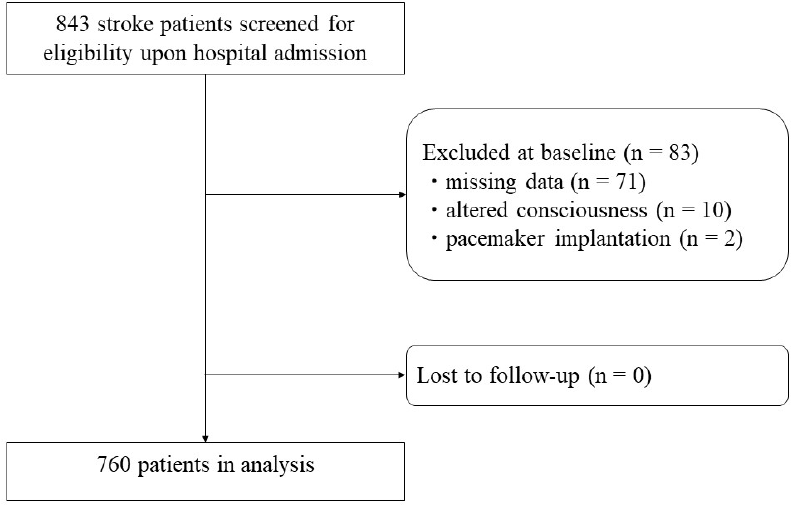
Figure 1. Flowchart of participant screening, inclusion criteria, and follow-up.